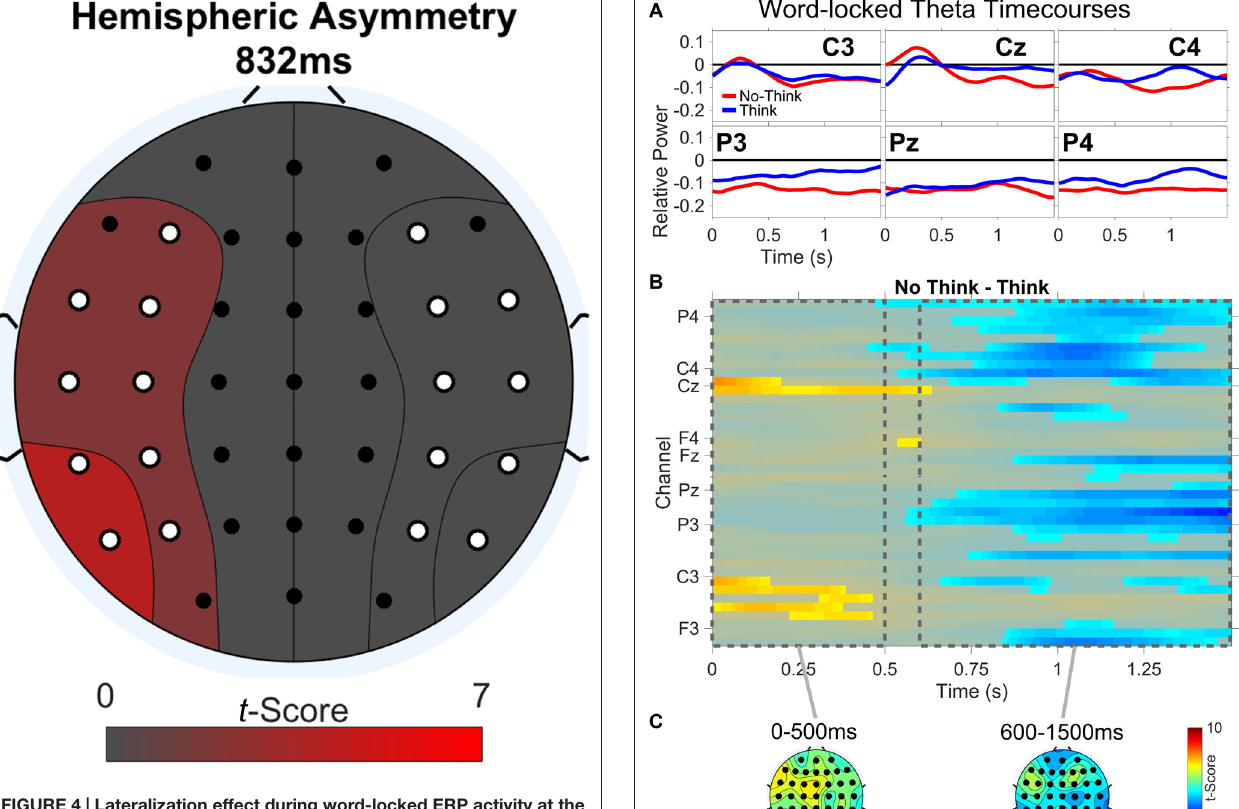
FIGURE 4 | Lateralization effect during word-locked ERP activity at the maximal condition difference. Difference scores larger than the opposite side of the head are depicted in red. Electrodes with significant differences p < 0.05 are colored in white.